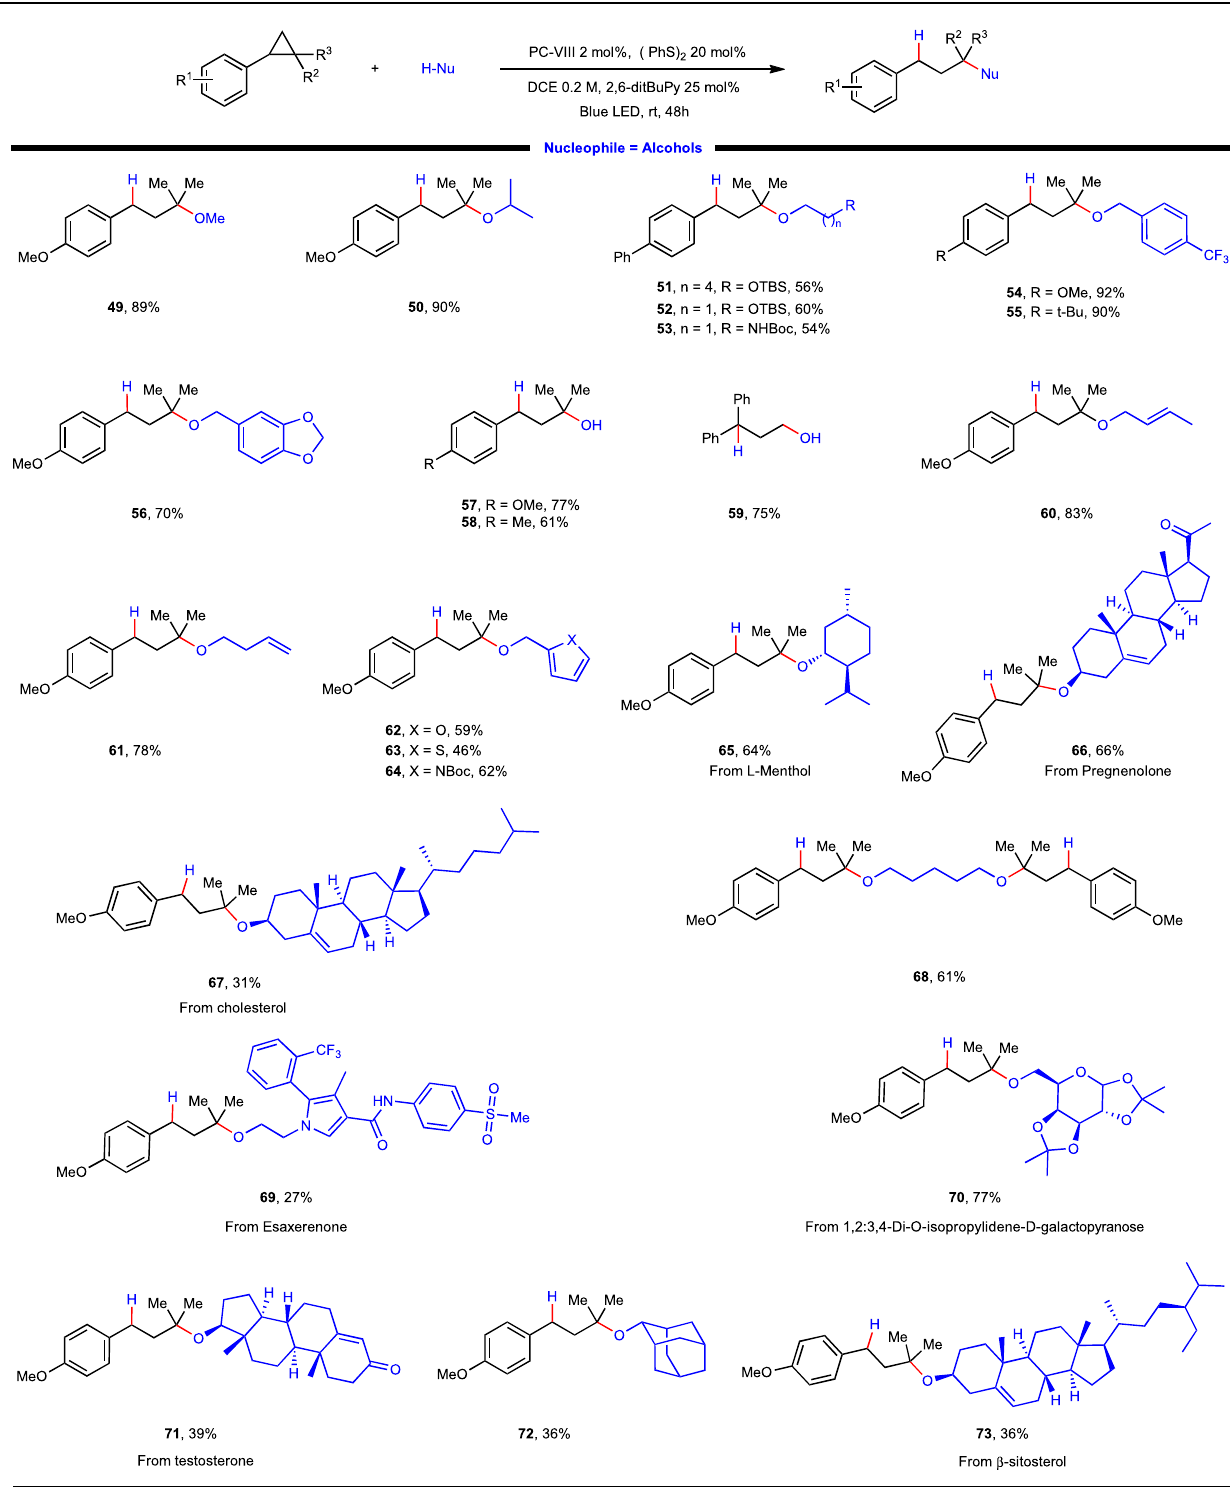
Fig. 3 | Substrate scope of photoredox-coupled C( sp 3 ) – heteroatom bond for- mation with alcohol as nucleophile. Reaction conditions: arylcyclopropane (0.2mmol, 1 equiv.), alcohol (0.4mmol, 2 equiv.), photocatalyst (2mol%), (PhS) 2 (0.04mmol, 0.2 equiv.), 2,6-ditBu-Py (0.05mmol, 0.25 equiv.) and DCE